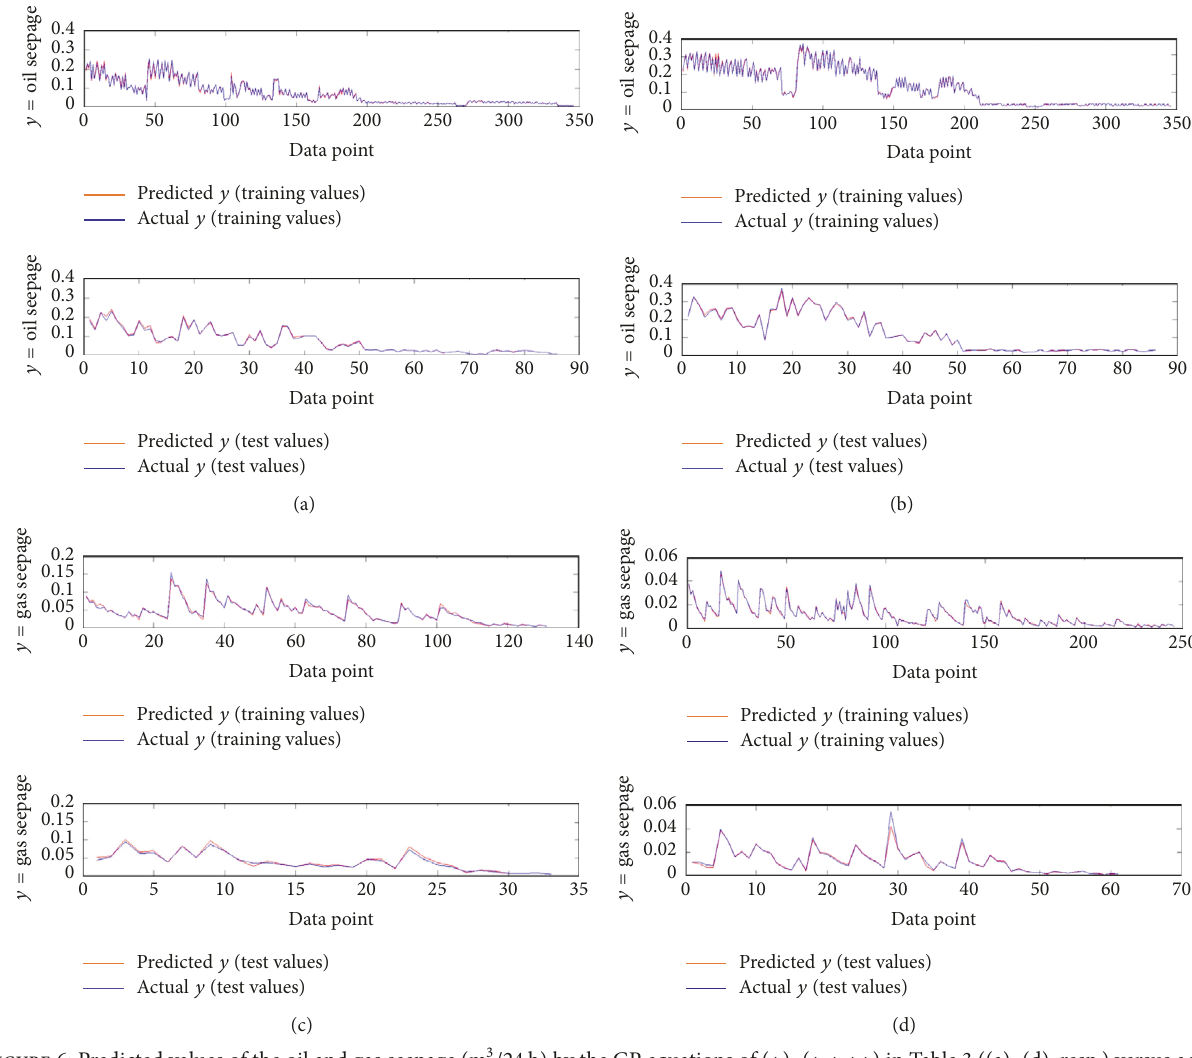
Figure 6: Predicted values of the oil and gas seepage (m 3 /24h) by the GP equations of ( ∗ )–( ∗ ∗ ∗∗ ) in Table 3 ((a)–(d), resp.) versus actual values for the training and test sets.